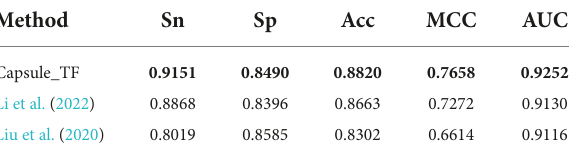
TABLE 1 Comparison with two states of the art methods in the independent test.